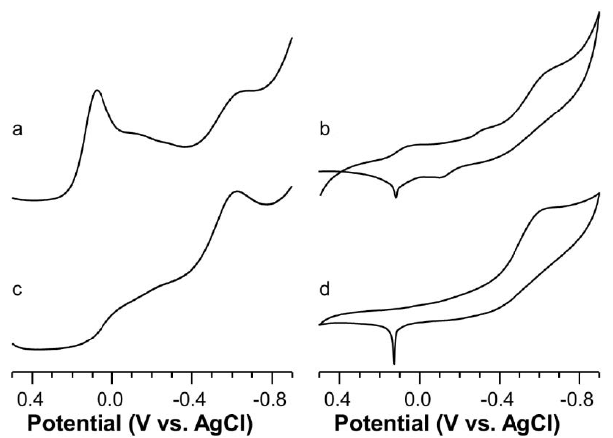
Figure 8. Square wave (left) and cyclic (right) voltammograms of Cu(II)-AcAng1-17 system (C L = 5 × 10 − 4 M, M:L 1.8:1, KNO 3 0.1 M) in aqueous solution as function of the pH: ( a , b ) 6.4; ( c , d )